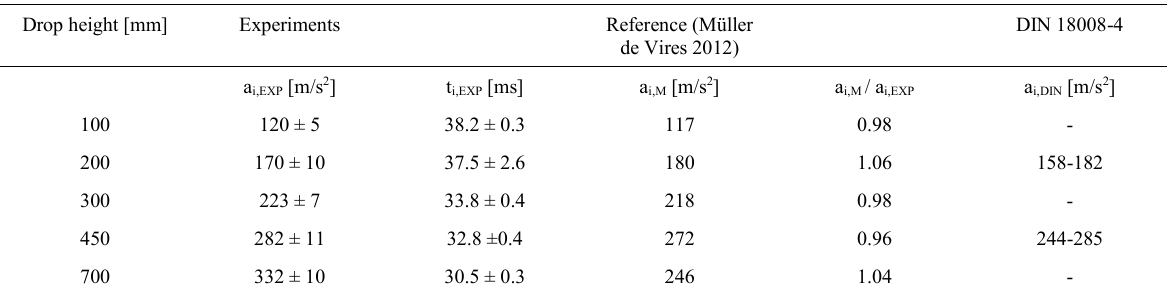
Table 3: Experimental results of impact on rigid object.